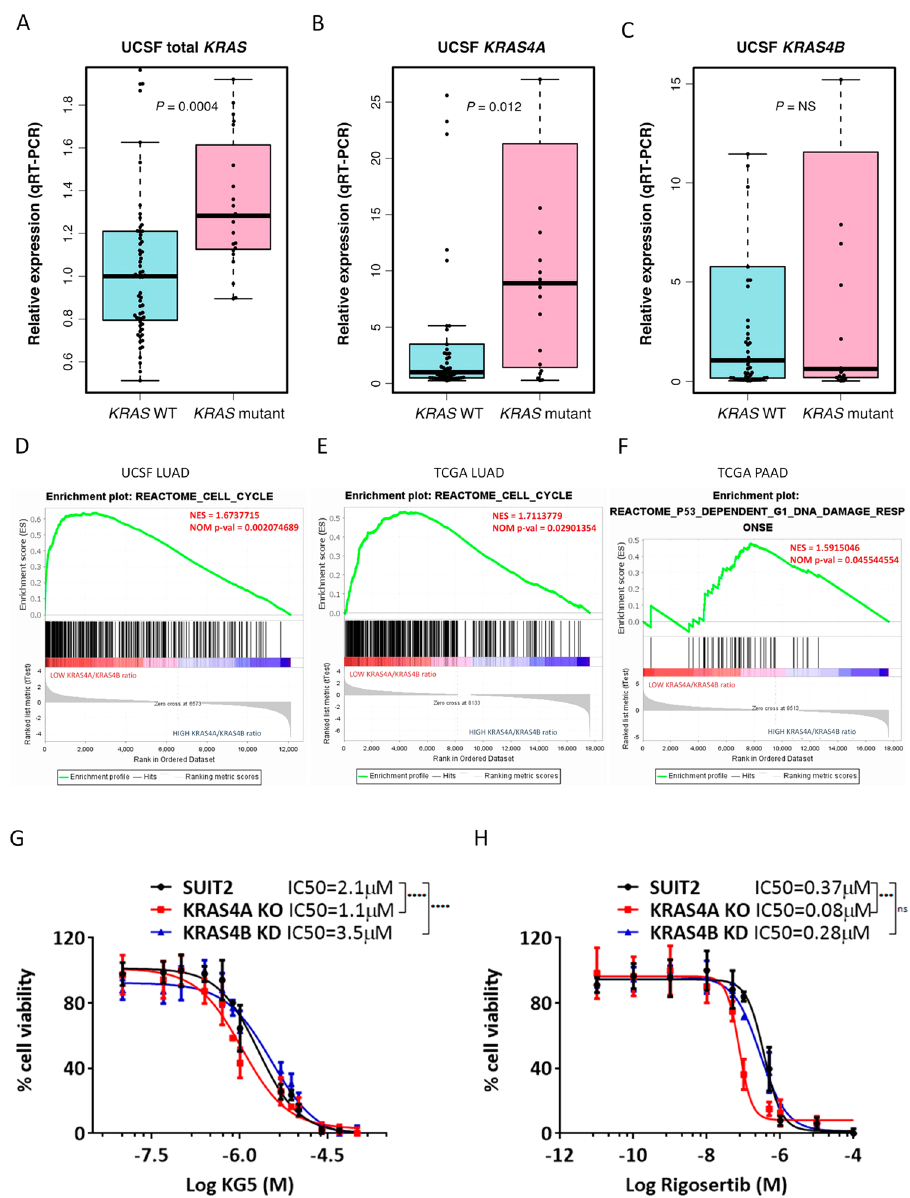
Fig. 6 Low levels of KRAS4A are associated with cell cycle/DNA damage gene expression signatures. A Total KRAS ; B KRAS4A ; and C KRAS4B expression in human lung cancers were determined by isoform-speci fi c TaqMan assays. The number of individual lung cancer patients with wildtype KRAS tumors ( n = 63) and mutant KRAS tumors ( n = 23) were analyzed. The center line is the median, the bottom of the box is the 25th percentile boundary, the top of the box the 75th, and the whiskers de fi ne the bounds of the data that are not considered outliers, with outliers de fi ned as greater/lesser than ± 1.5 × IQR, where IQR = inter quartile range. ( D – F ) GSEA plots for functional gene sets enriched in low KRAS4A/KRAS4B ratio tumors in UCSF ( D ) and TCGA lung ( E ) and pancreas ( F ) data sets. Tumors with a low ratio of KRAS4A/KRAS4B have higher expression of genes linked to cell cycle and mitosis. Treatment with KG5 ( G ) or Rigosertib ( H ) signi fi cantly impaired growth of the KRAS4A knockout SUIT2 cells compared to the parental or KRAS4B knockdown cells. Cells were treated with inhibitors for 72 h and cell counts measured using the Cyquant assay. Data are presented as mean ± s.d from n = 7 independent experiments in ( G ) and n = 3 independent experiments in ( H ). *** P < 0.001; **** P < 0.0001 by two-way ANOVA with Dunnett ’ s multiple Colony formation . Cells were plated at density of 500 cells per well in six-well plate stained with crystal violet and the images were captured using microscope followed by quanti fi cation of colony area using Image-Pro Plus software. and incubated for 10 days at 37 °C in DMEM medium containing 10% fetal bovine serum and 1% penicilin-streptamycin. Colonies were counted after methanol fi xation and crystal violet staining. Xenograft tumor model . SUIT2 cells (4 ×10 6 ) and A549 cells (3 × 10 6 ) were dispersed in 75 μ L DMEM and 75 μ L Matrigel (356230, BD Biosciences) and Soft agar growth assays . In total 5,000 cells were mixed with 1ml of 0.3% agar in injected subcutaneously into nude mice. Tumor volume was calculated as follows: DMEM supplemented with 10% FBS and layered onto 1.5 ml 0.6% agar in DMEM V = L ×W 2 ×0.52, where L and W represent length and width respectively. For the supplemented with 10% FBS. The colonies were incubated for 2 weeks in SUIT2 in vivo ef fi cacy of indisulam study, NSG mice were implanted with 2× 10 6 SUIT2 cells and for 3 weeks in A549 cells. At the end of incubation, the colonies were or 3 ×10 6 A549 mixed with matrigel. After cell implantation for 5 days, the